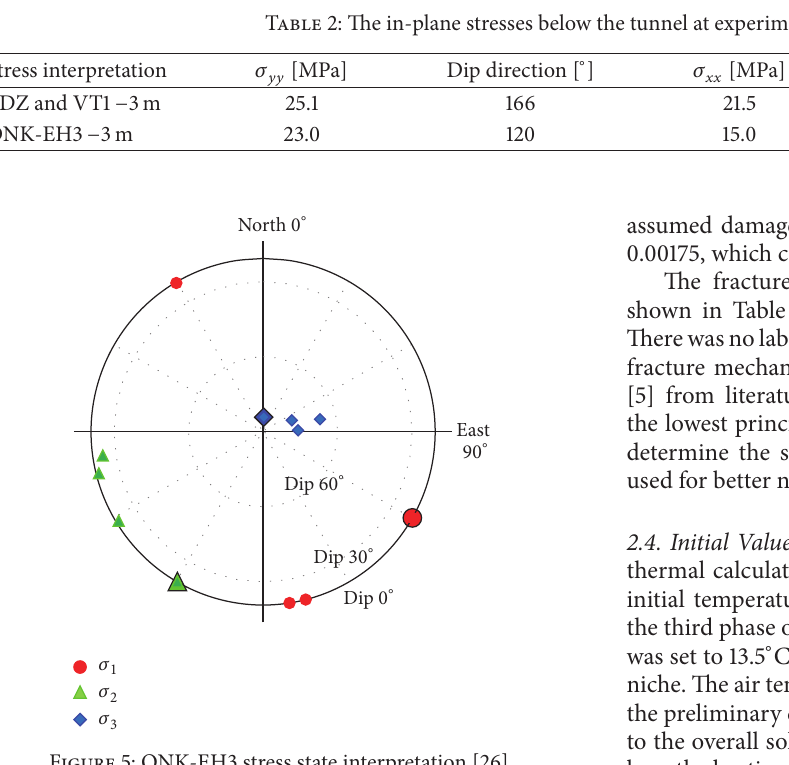
Figure 5: ONK-EH3 stress state interpretation